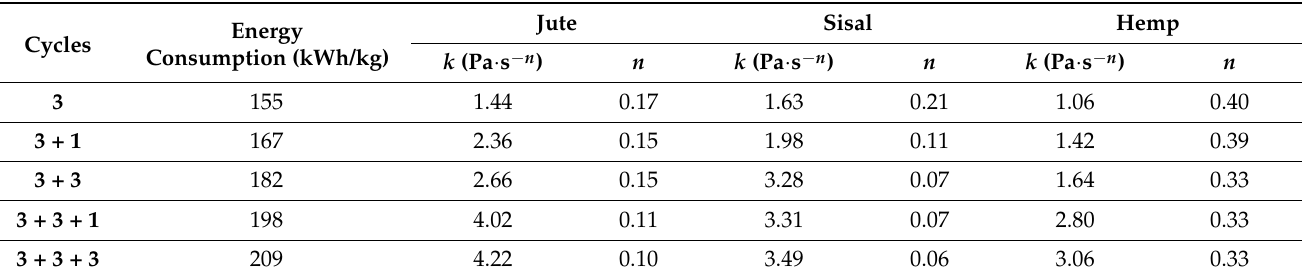
Table 4. Energy consumption and Ostwald–de Waele fitting parameters, both the consistency factor ( k ) and the flow behavior index ( n ), for mechanical MCNF.